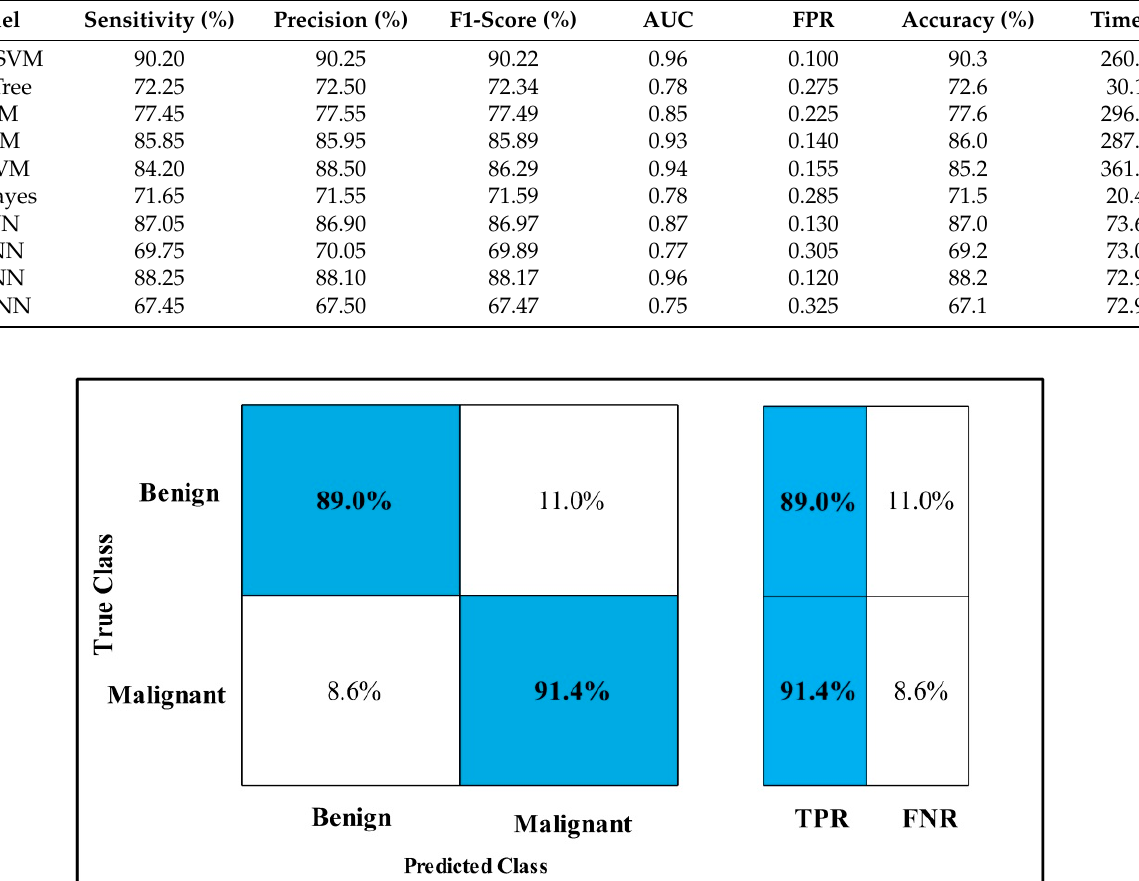
Table 3. Classification results using Fine-tuned Nasnet deep features for CBIS-DDSM. Models